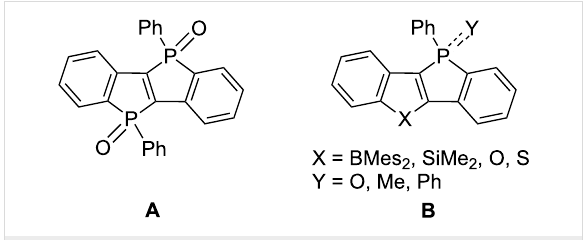
Figure 1: Phosphole-based tetracyclic